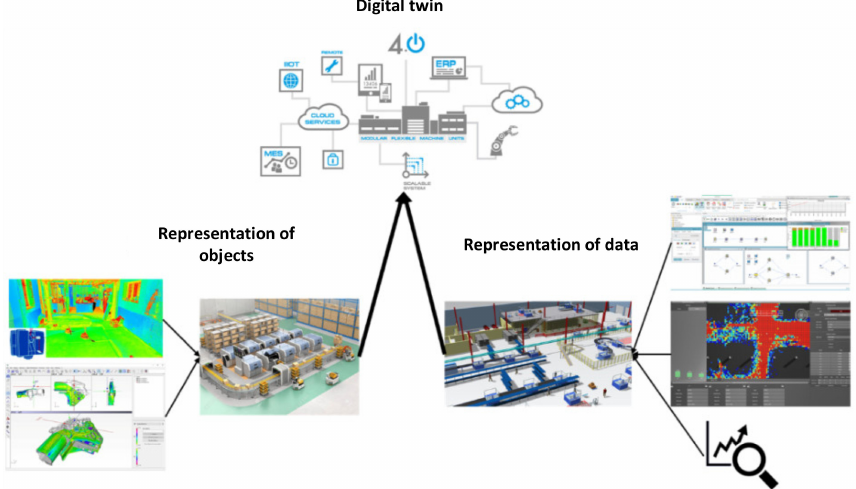
Figure 4. The virtual part of the system for verification of logistics